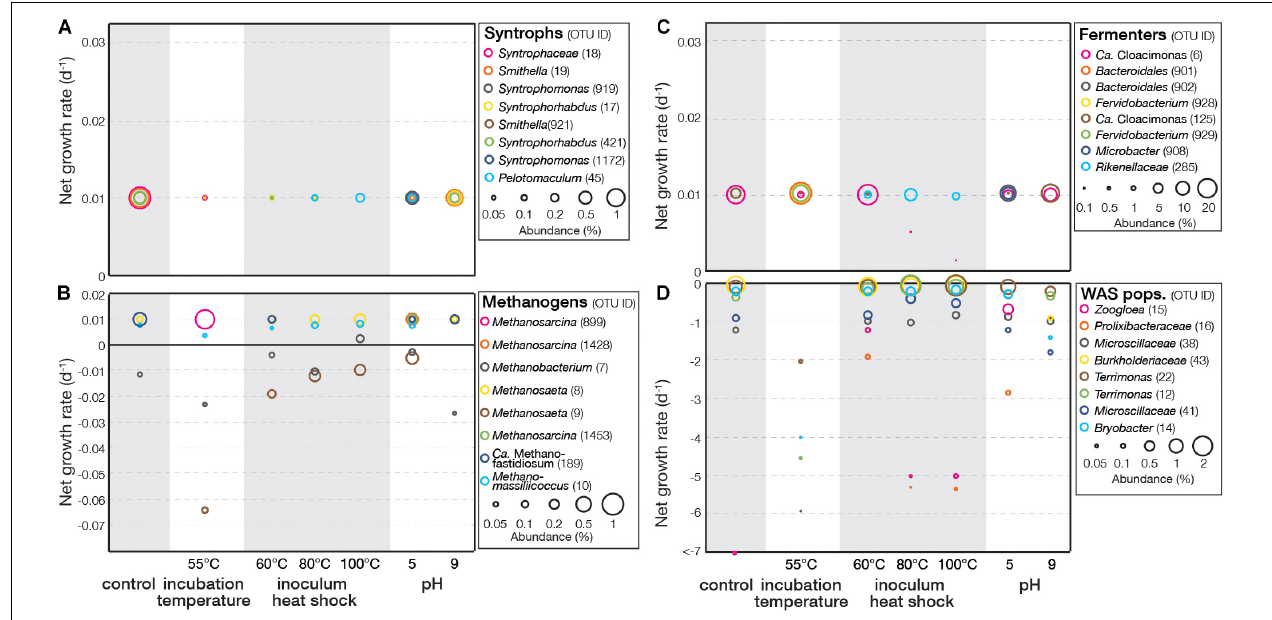
FIGURE 2 | Net growth rate of representative OTUs (top eight abundant) related to syntrophs, methanogens, fermenters, and WAS populations in (A–D) experiment I.